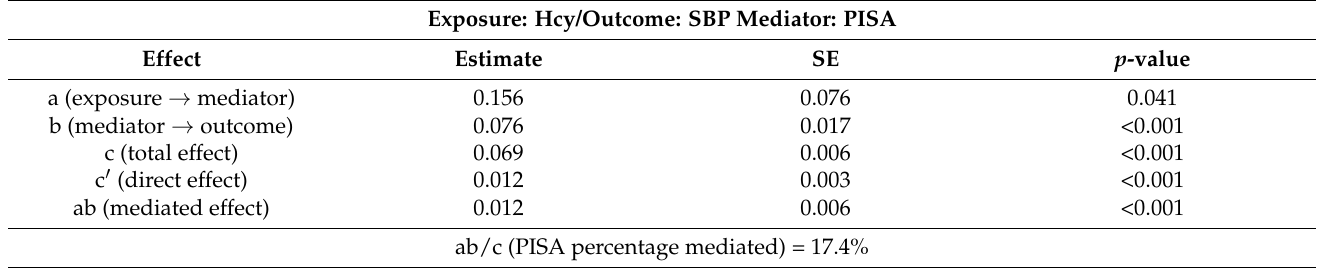
Table 4. Mediation analysis of the effects of PISA and PESA on the association of Hcy levels with SBP ( n = 4021). Exposure: Hcy/Outcome: SBP Mediator: